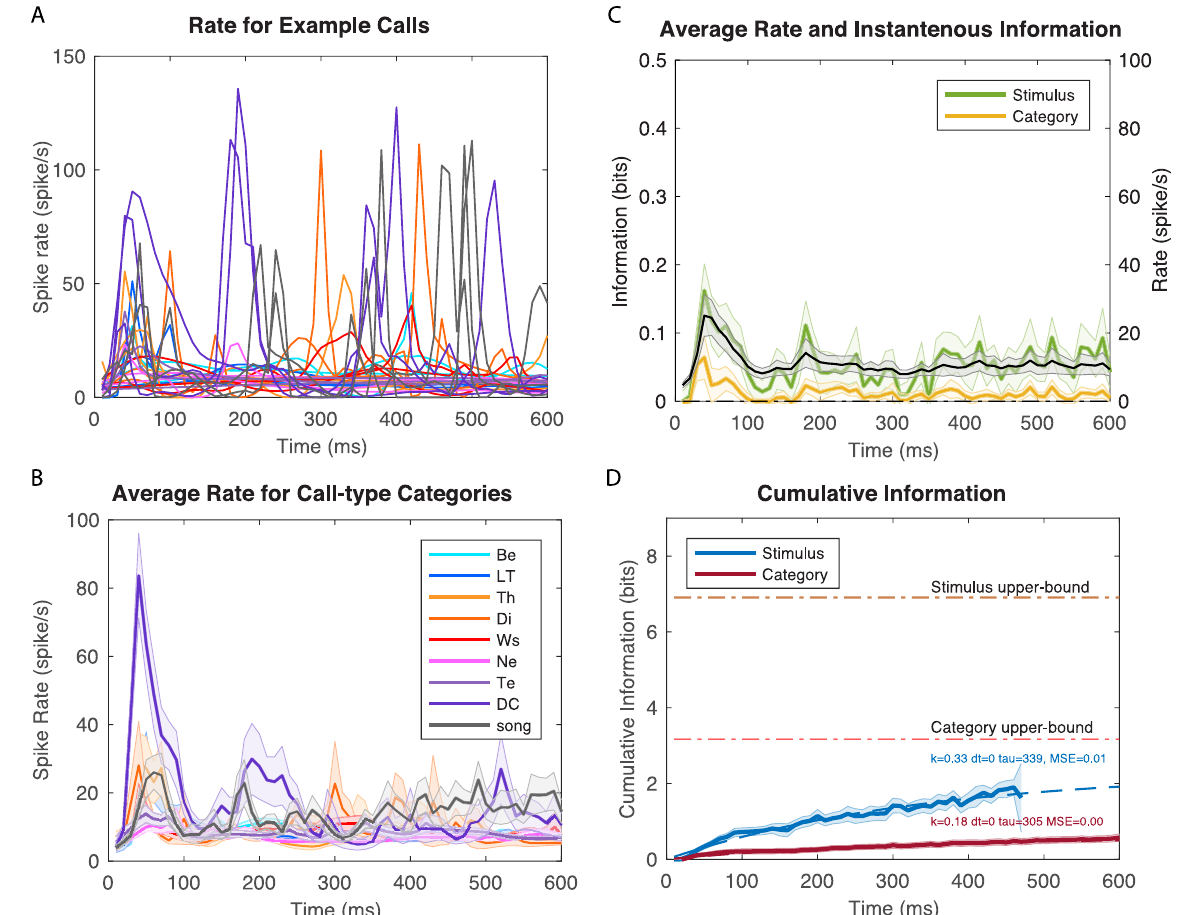
Fig 4. Time-varying firing rates and information values for example neuron 2. As in Fig 3 but for a neuron with lower firing rates and displaying selectivity for Distance Calls. Spike rasters for this neuron are shown on S5 Fig. A . Time-varying firing rate obtained from KDE of ten repetitions of different example stimuli. B . Averaged time-varying firing rate obtained for each call-type category. C . Overall time-varying firing rate and instantaneous information for stimuli and call-type categories. D . Cumulative information for stimuli and call-type categories. See details in legend of Fig